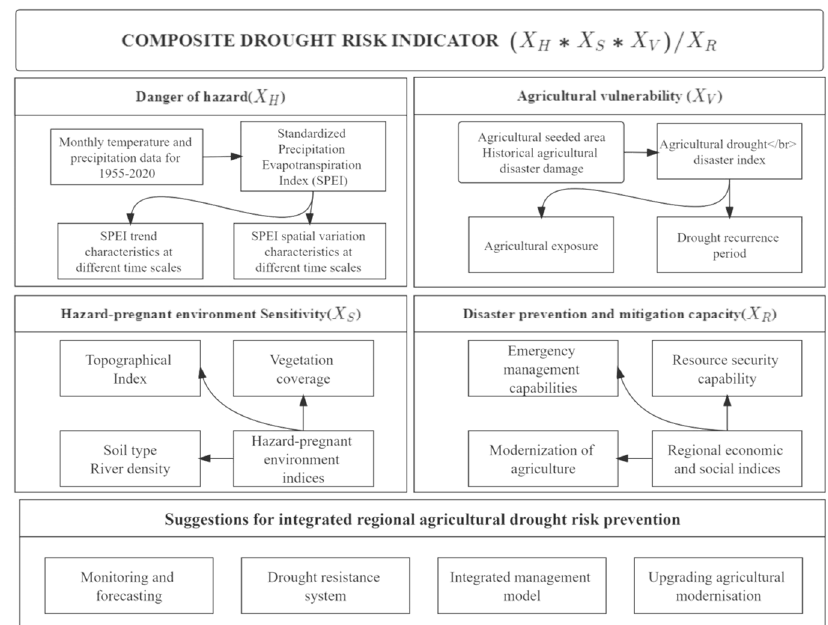
Figure 2. Research